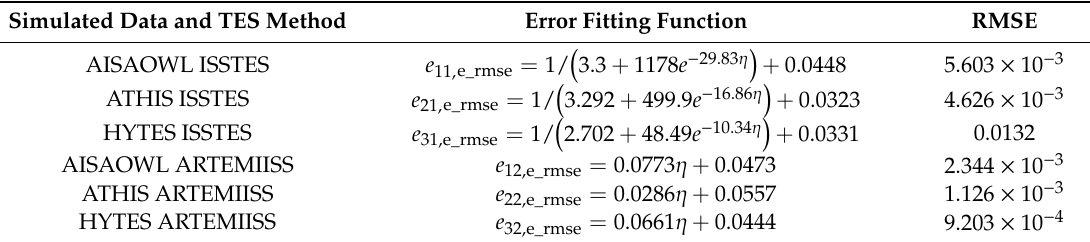
Table 8. The LSE RMSE error fitting function about